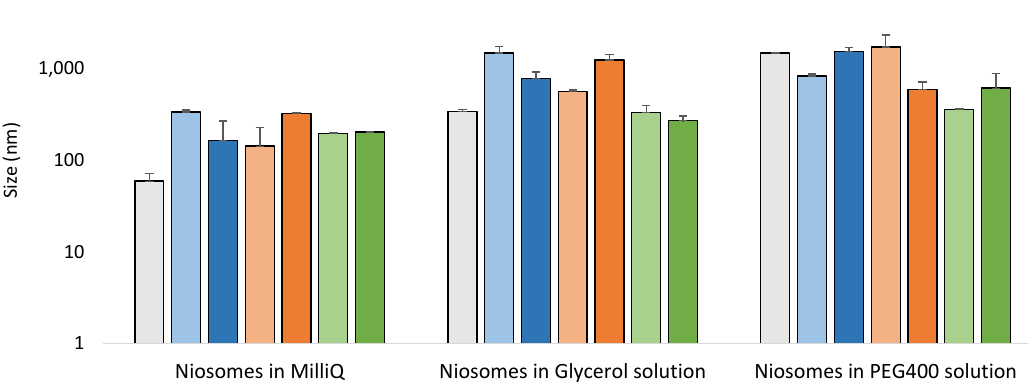
Figure 7. Comparison of size between initial formulations and the formulations at pH 2, pH 7 and pH 9 on day 0 and after 3 days.